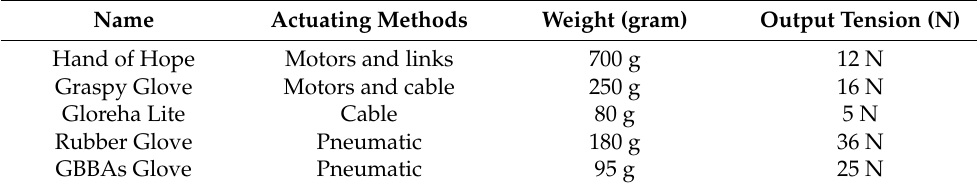
Table 3. Original design parameters of elliptical